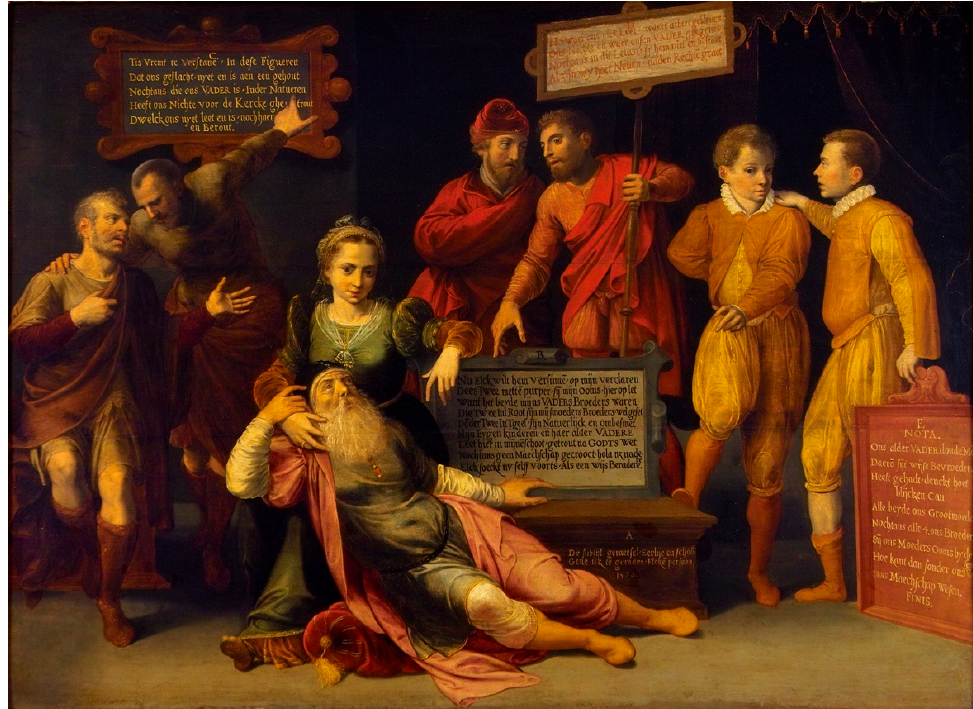
Figure 5. Cornelis Ketel (attribution). Riddle of Nijmegen , 1576, Museum Het Valkhof, Nijmegen, Netherlands, inventory number: C.XVI.233. Oil painting on wood, 78.5 cm × 107.5 cm. Photo: Museum Het Valkhof, Nijmegen, The Netherlands.